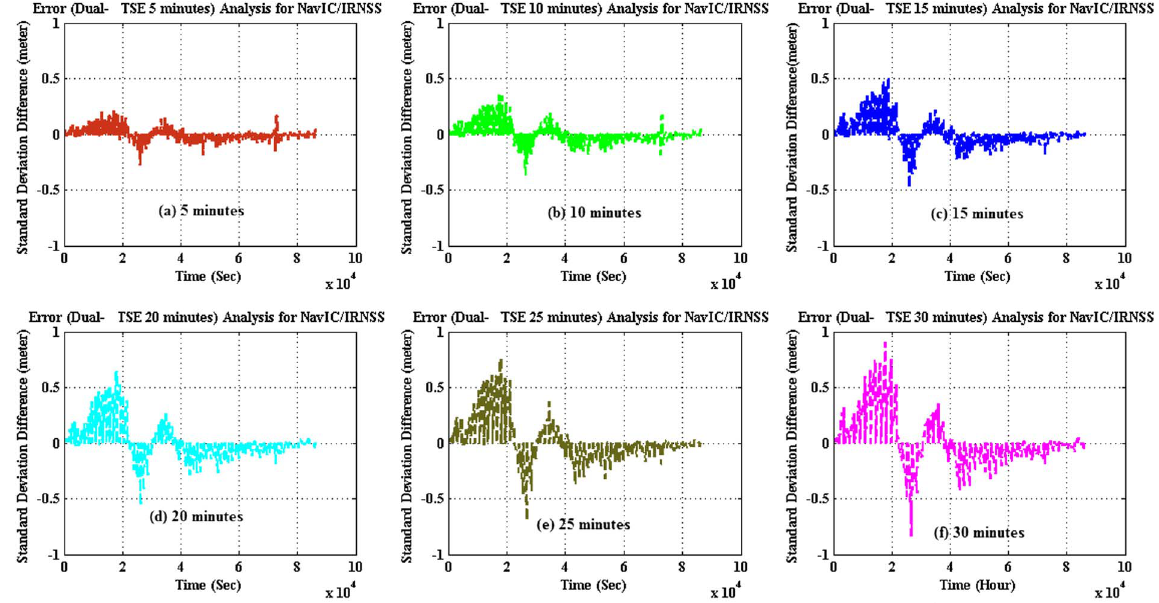
Fig. 17. TSE standard deviation error analysis for Broadcasting Interval (a) 5 min, (b) 10 min, (c) 15 min, (d) 20 min, (e) 25 min, and (f) 30 min.